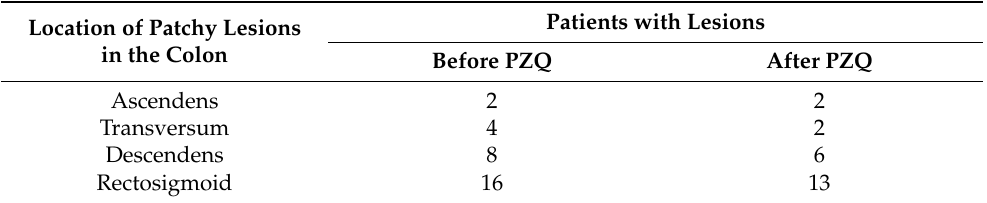
Rectosigmoid PZQ, praziquantel.